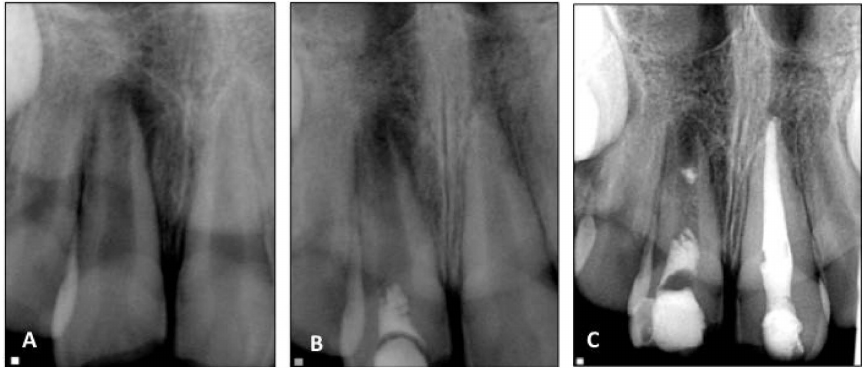
Figure 4. Radiographs of revascularized human immature permanent tooth #8. ( A ) Preoperative radiograph to show inflammatory periapical lesion; ( B ) Postoperative radiograph after regenerative endodontic procedures; ( C ) At 12-month follow-up, no thickening of the canal walls and no continued root maturation are